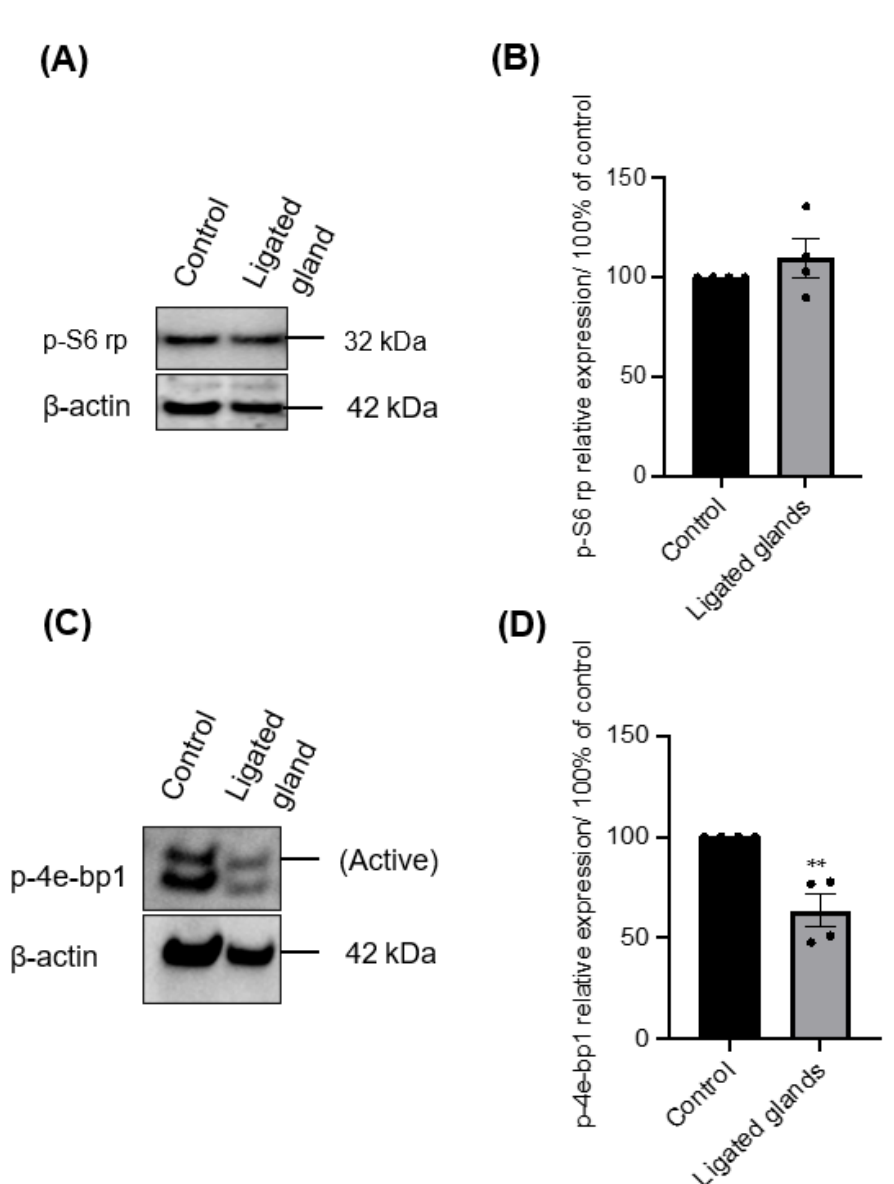
Figure 7. ( A ) Immunoblotting of p-S6 rp of growing salispheres from an unoperated gland (control) and from the ligated gland on day 8 of culture. ( B ) The phosphorylation of p-S6 rp in salispheres from ligated glands appeared comparable ( p = 0.3570) to that in salispheres from unoperated glands. ( C ) Immunoblotting of p-4e-bp1 of growing salispheres from an unoperated gland (control) and from the ligated gland. ( D ) The phosphorylation of 4e-bp1 was significantly inhibited in grown salispheres from ligated glands (** p < 0.005). Data are expressed as mean ± S.E.M ( n = 4).